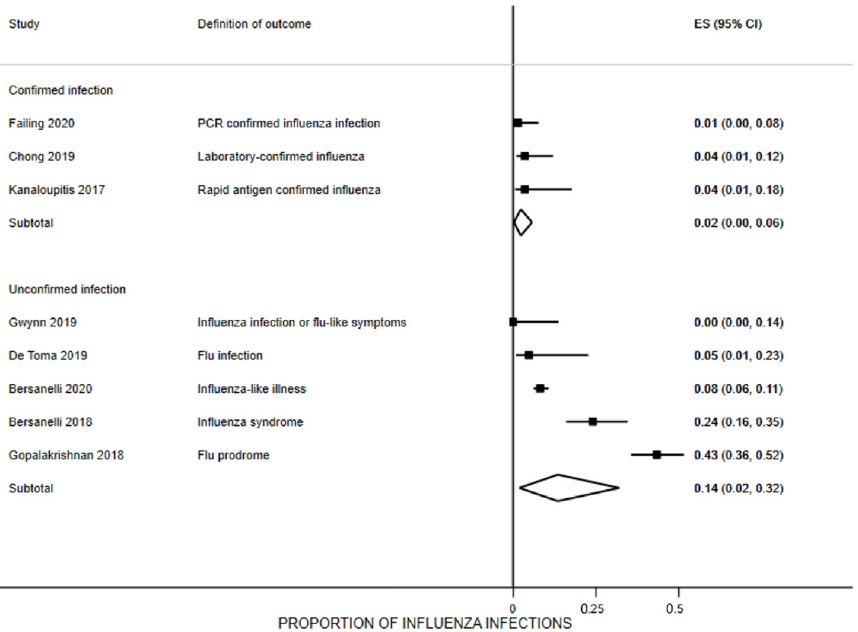
Figure 4. Proportion of patients receiving immune checkpoint inhibitors with influenza infection (confirmed or unconfirmed) after vaccination. For Bersanelli 2020 [23–25], numbers account only for patients without COVID infection.